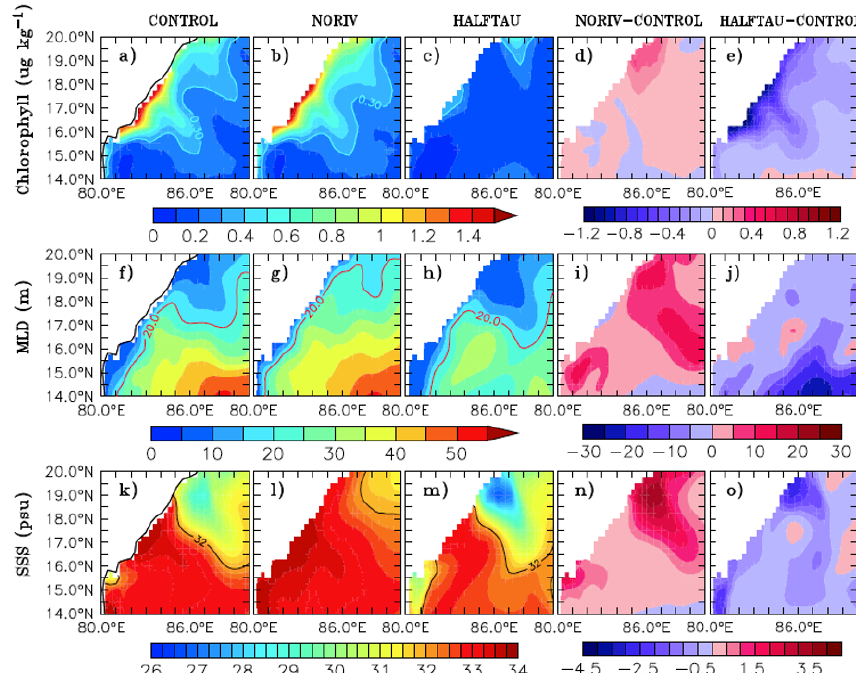
Figure 19. Forcing mechanisms of upwelling-induced chlorophyll distribution in the northwestern Bay of Bengal. Comparison of model- simulated surface (a–e) chlorophyll, (f–j) mixed-layer depth (MLD), and (k–o) sea surface salinity (SSS) from the CONTROL, NORIV, and HALFTAU experiments (defined at the end of this caption) averaged for the month of August. Contours shown are for chlorophyll, MLD, and salinity of 0.3µgkg − 1 , 20m, and 32psu, respectively. Shown are model simulations from a control run which included all the forcings (CONTROL), without river runoff (NORIV), and with the magnitude of wind stress reduced by 50% (HALFTAU) (from Thushara and Vinayachandran,